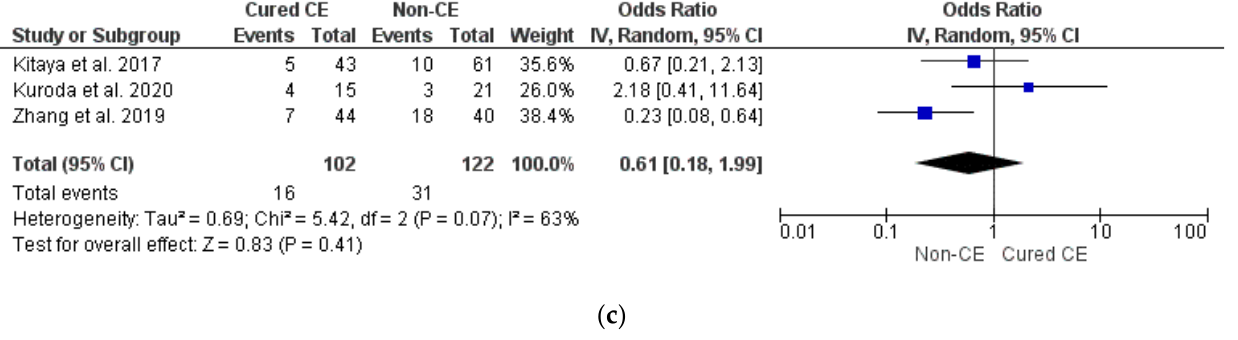
Figure 4. Pooled data analysis comparing non-CE versus cured CE: ( a ) ongoing pregnancy rate/live birth rate; ( b ) clinical pregnancy rate; ( c ) miscarriage rate [8,12,34].